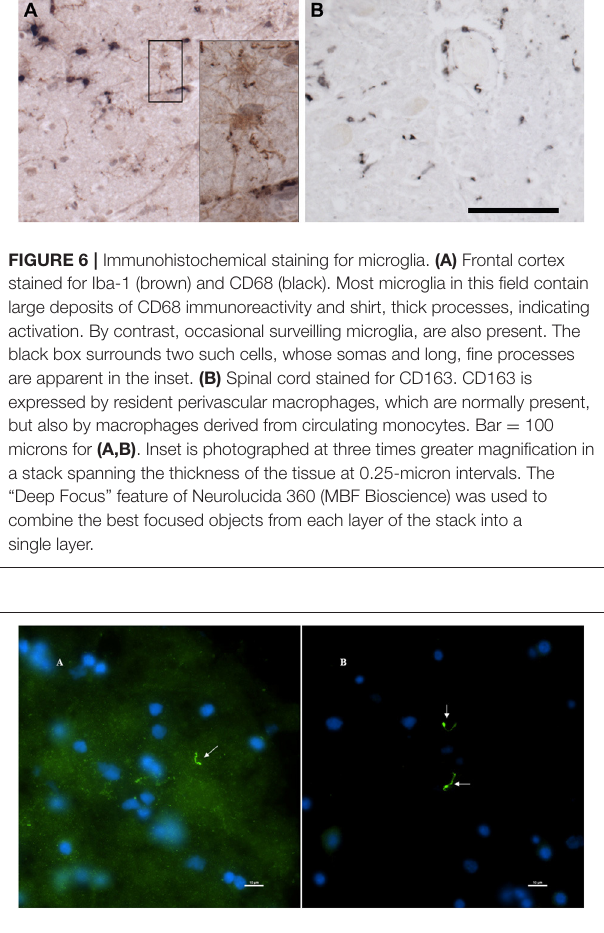
FIGURE 7 | Non-human primate (MJ 61) frontal cortex tissue was incubated with Borrelia burgdorferi ex-vivo . These ex-vivo tissues were fixed, sectioned at 10 µ m, and stained against Borrelial spirochetes. (A,B) Are representative images of positive staining of Borrelial spirochetes. White arrows were pointed toward Borrelial spirochetes that were stained with primary rabbit polyclonal anti-Borrelia antibody and secondary Goat anti-rabbit IgG antibody conjugated to Alexafluor 488. To increase the signal intensity, (B) was incubated with Autofluorescence quencher after completion of immunofluorescence that caused a significant decrease in the autofluorescence caused by lipofuscin and aldehyde fixation. Scale bars − 10 µ m. Image was acquired with a Nikon fluorescence microscope using a 40x